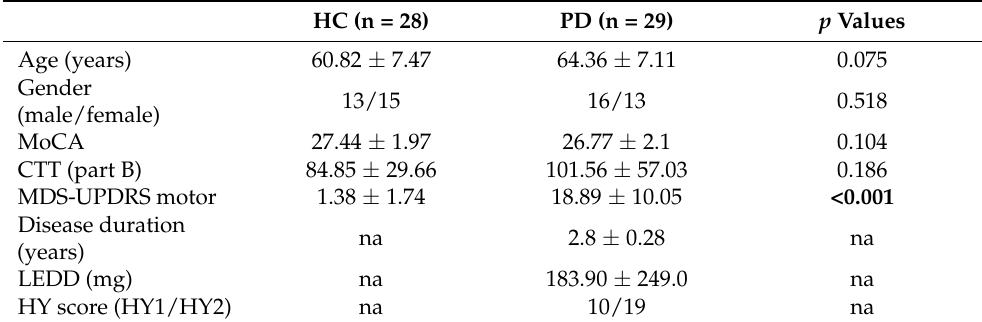
Table 1. Participants’ Characteristics.